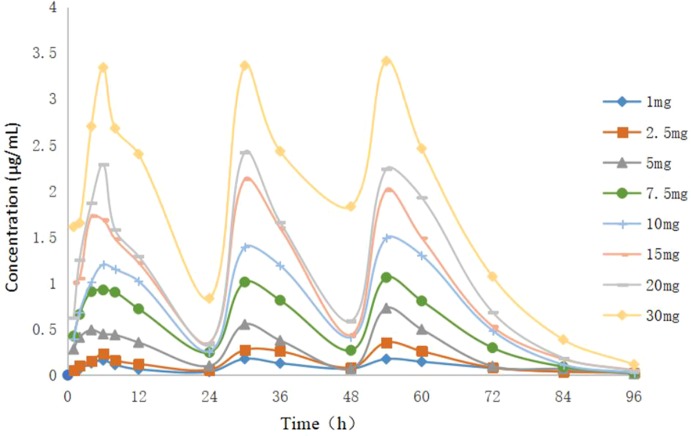
Concentration–time curve of doxycycline in the dynamic mode.